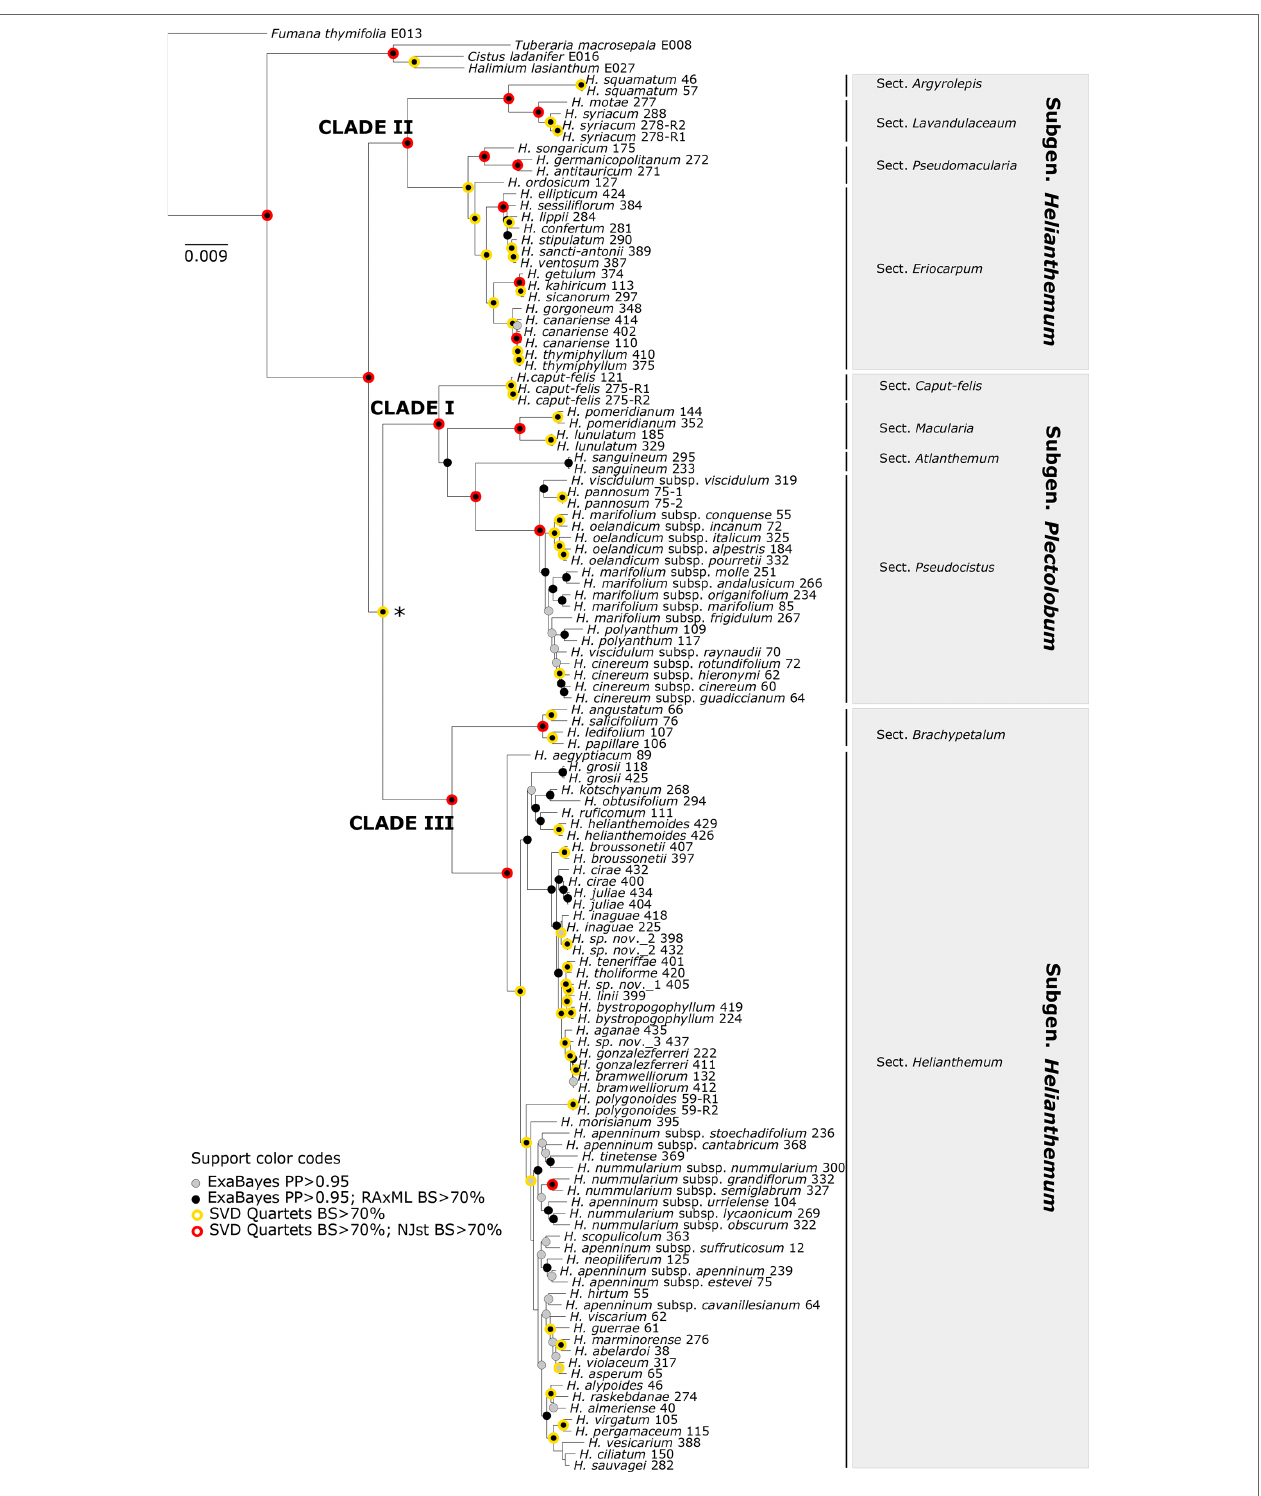
FIGURE 5 | The 50% majority-rule consensus tree obtained from Bayesian analysis of Helianthemum GBS data in ExaBayes using the most robust assembly (MinError configuration under 15% minimum taxon coverage). Circles of different colours indicate clades that are supported in the two concatenated (ExaBayes, RAxML) and the two coalescent (SVDquartets, NJst) phylogenetic analyses. The intrageneric taxonomic assignments of taxa (sections and subgenera) follow López- González (1993) and Aparicio et al. (2017). The asterisk denotes the single clade for which NJst provided high bootstrap support but SVDquartets did not. There were no clades with RAxML BS > 70 but ExaBayes PP >